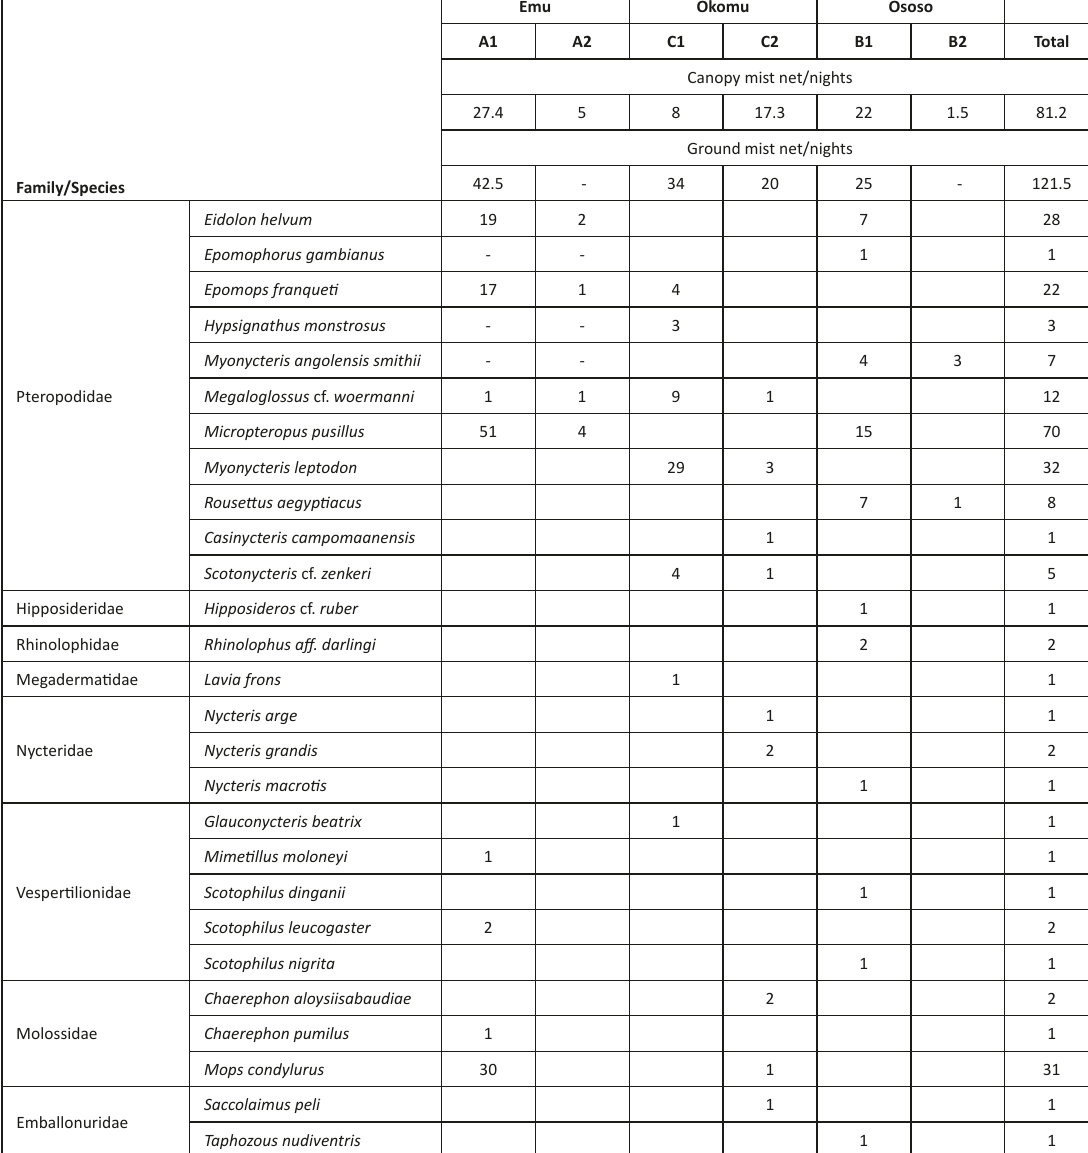
Table 1. Capture effort and the number of individuals of the 27 bat species captured from the three survey localities